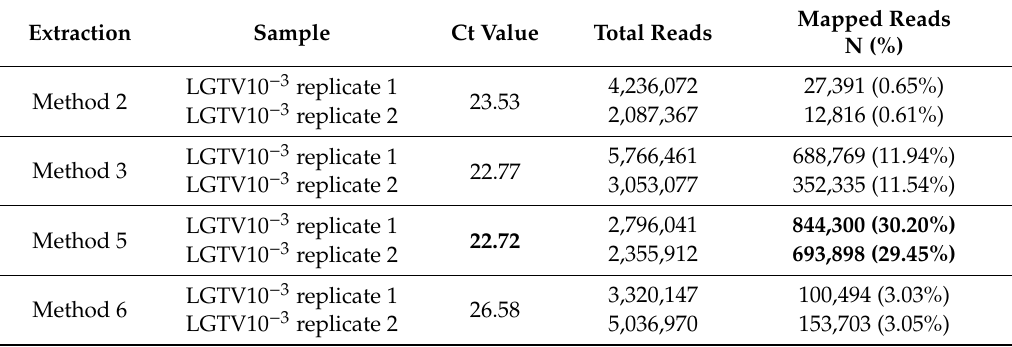
Table 4. Recovered viral reads by mNGS sequence analysis based on further assessment of extraction methods (Method 2, 3, 5, and 6) for metagenomic identification of viral vector-borne pathogens. Ct: cycle threshold. The best result is indicated in